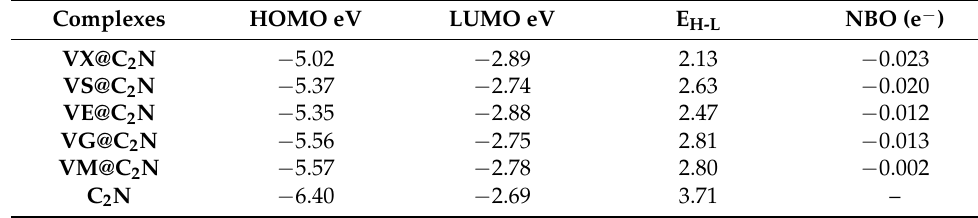
Table 4. FMO and NBO results of most stable V-series@C 2 N